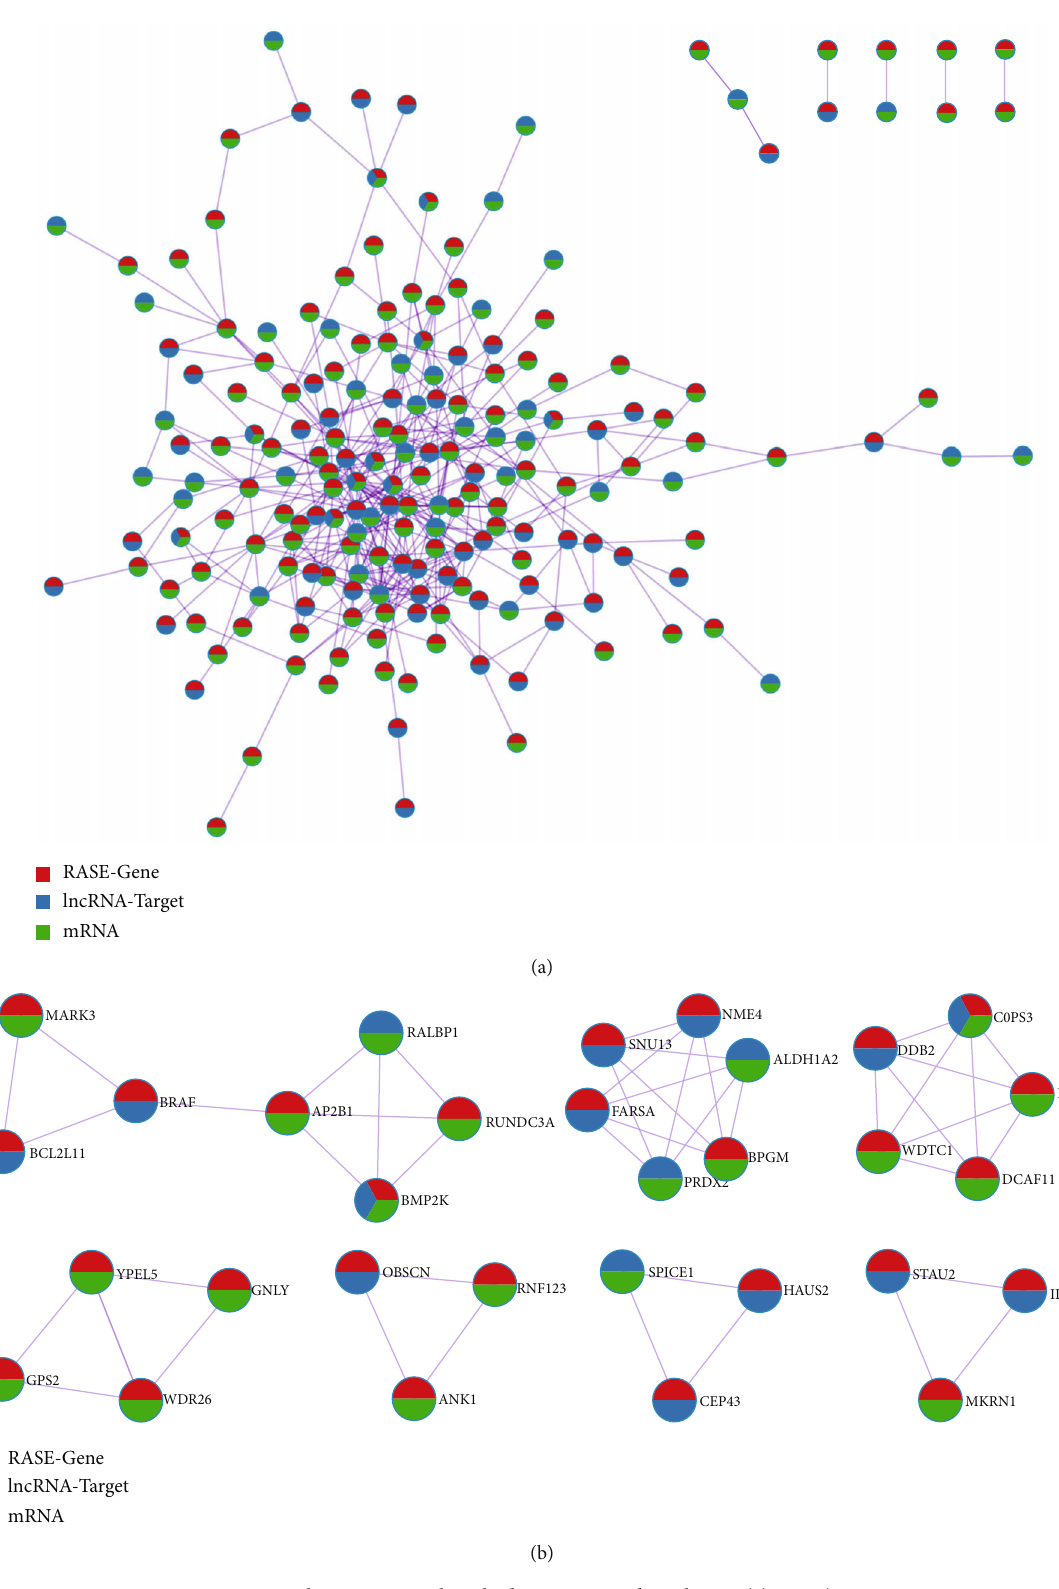
Figure 5: Protein-protein interaction analysis associated with decompensated cirrhosis. (a) PPI (protein-protein interaction) network obtained from DE-mRNAs, DE-lncRNA target genes, and RASE genes. (b) MCODE algorithm was then applied to this network to identify neighborhoods where proteins were densely connected. Network nodes were displayed as pies. Color code for pie sector represented the gene list with the di ff erent